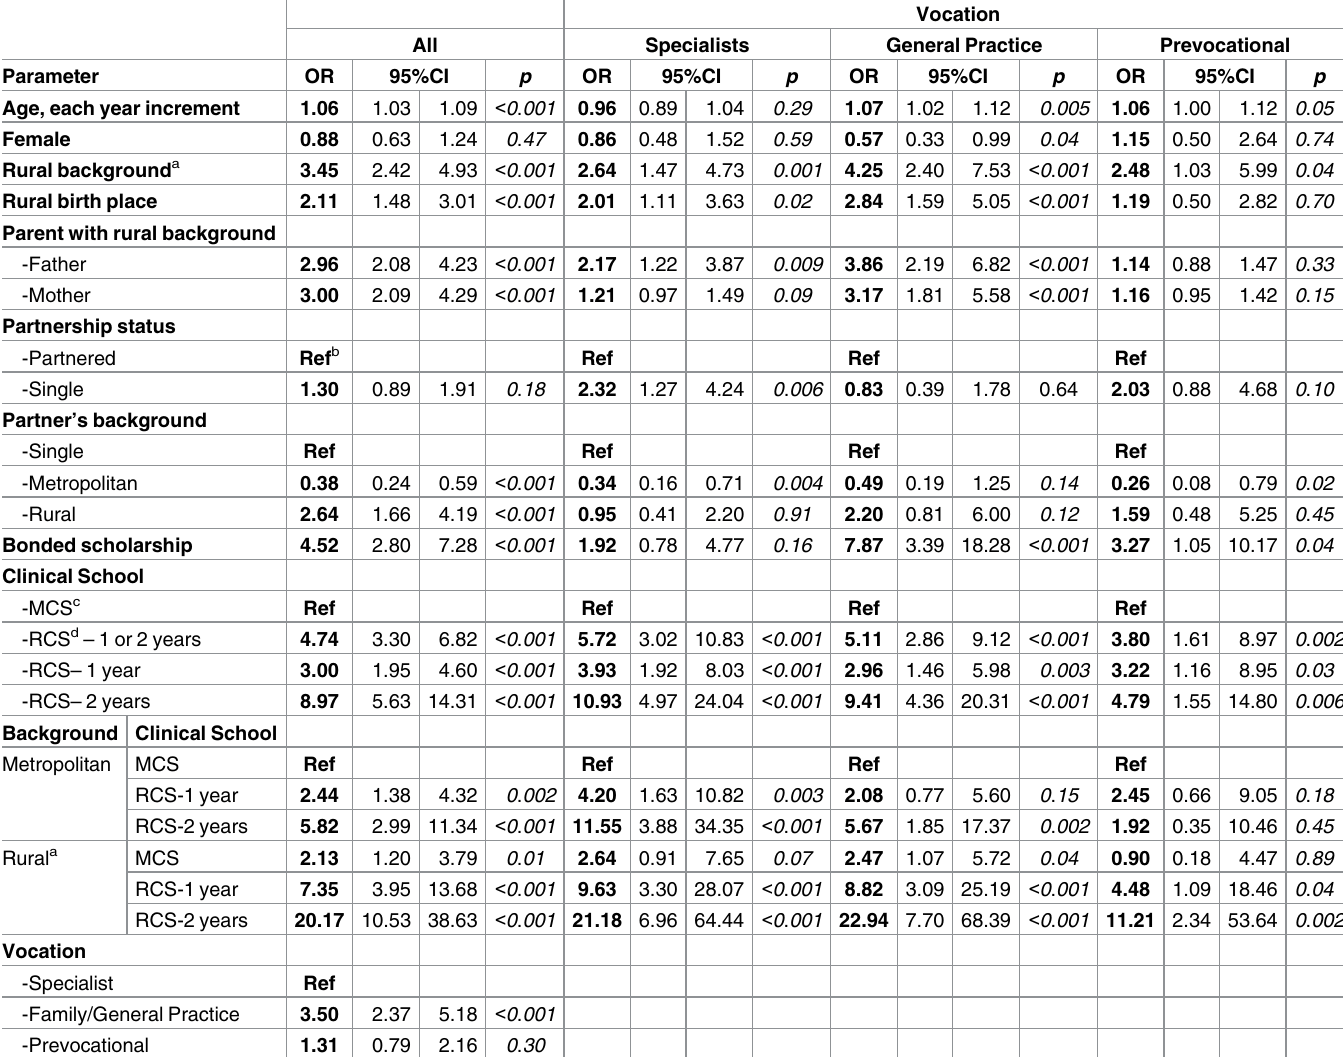
Table 2. Association of exposures with rural practice (cid:21) 50% of time since